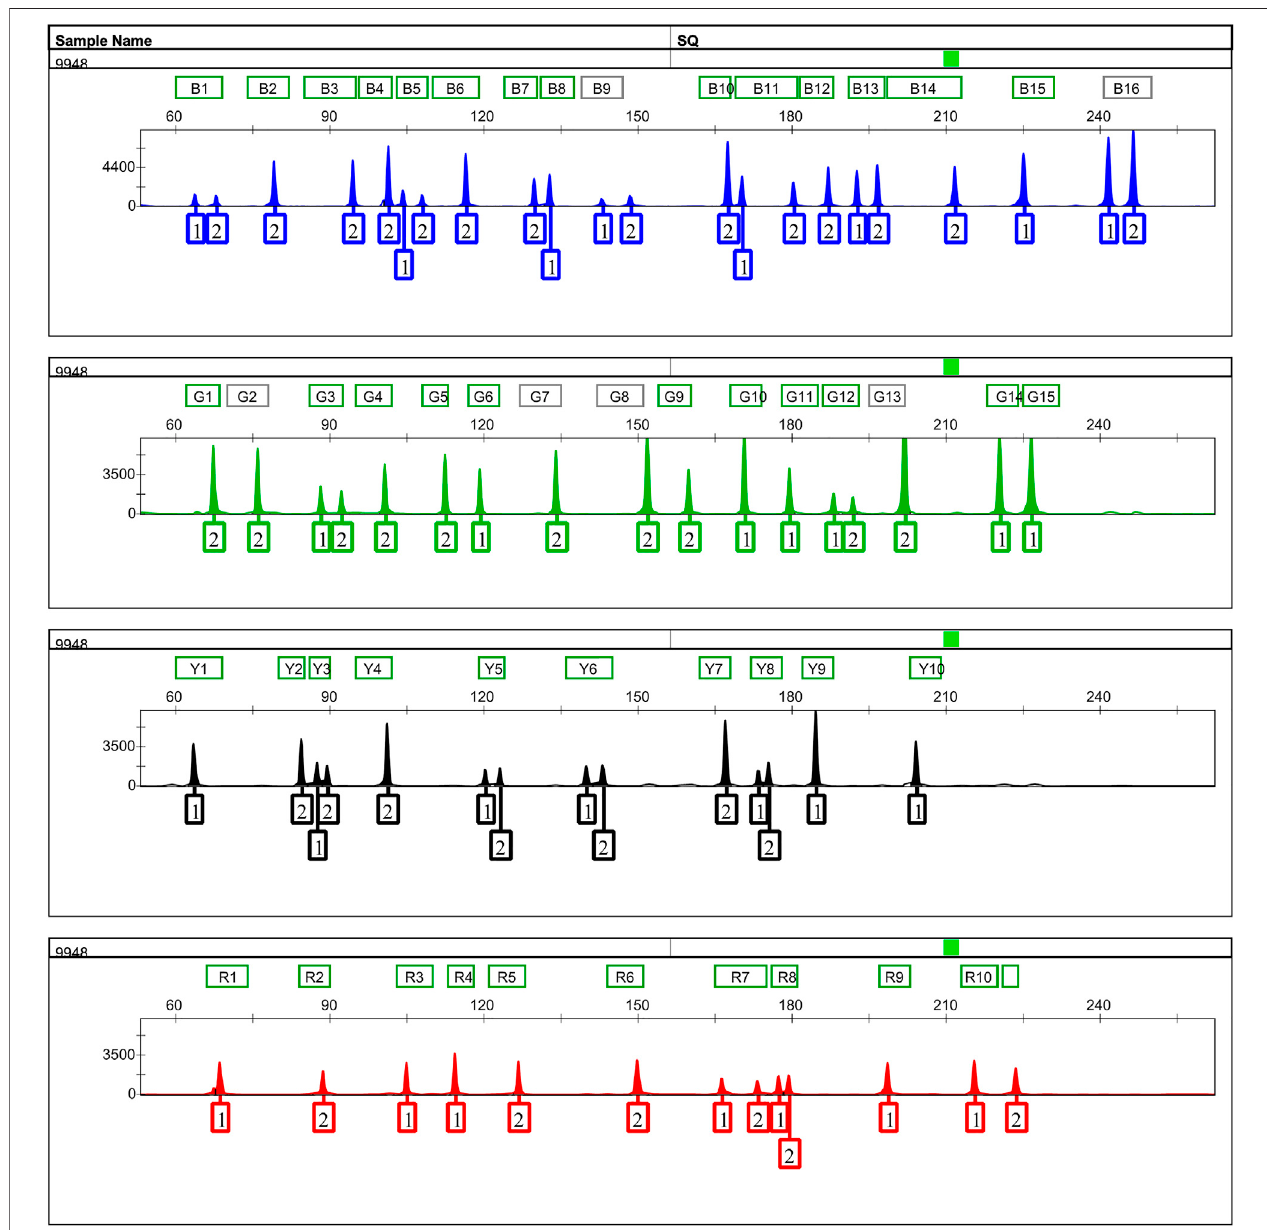
FIGURE 1 | Representative 500 pg of Control DNA 9948 pro fi le ampli fi ed with the 52-AIDIP panel for 25- μ l reaction volumes. Five hundred picograms of Control DNA9948wasampli fi edwiththedevelopedpanelfor30cycles.OnemicroliterofPCRproductaddedinto12.5 μ lofloadingmixtures(12 μ lHi-Diformamide+0.5 μ lSIZ- 500 Size Standard) was electrophoresed on a 3500xL Genetic Analyzer using the default injection conditions.